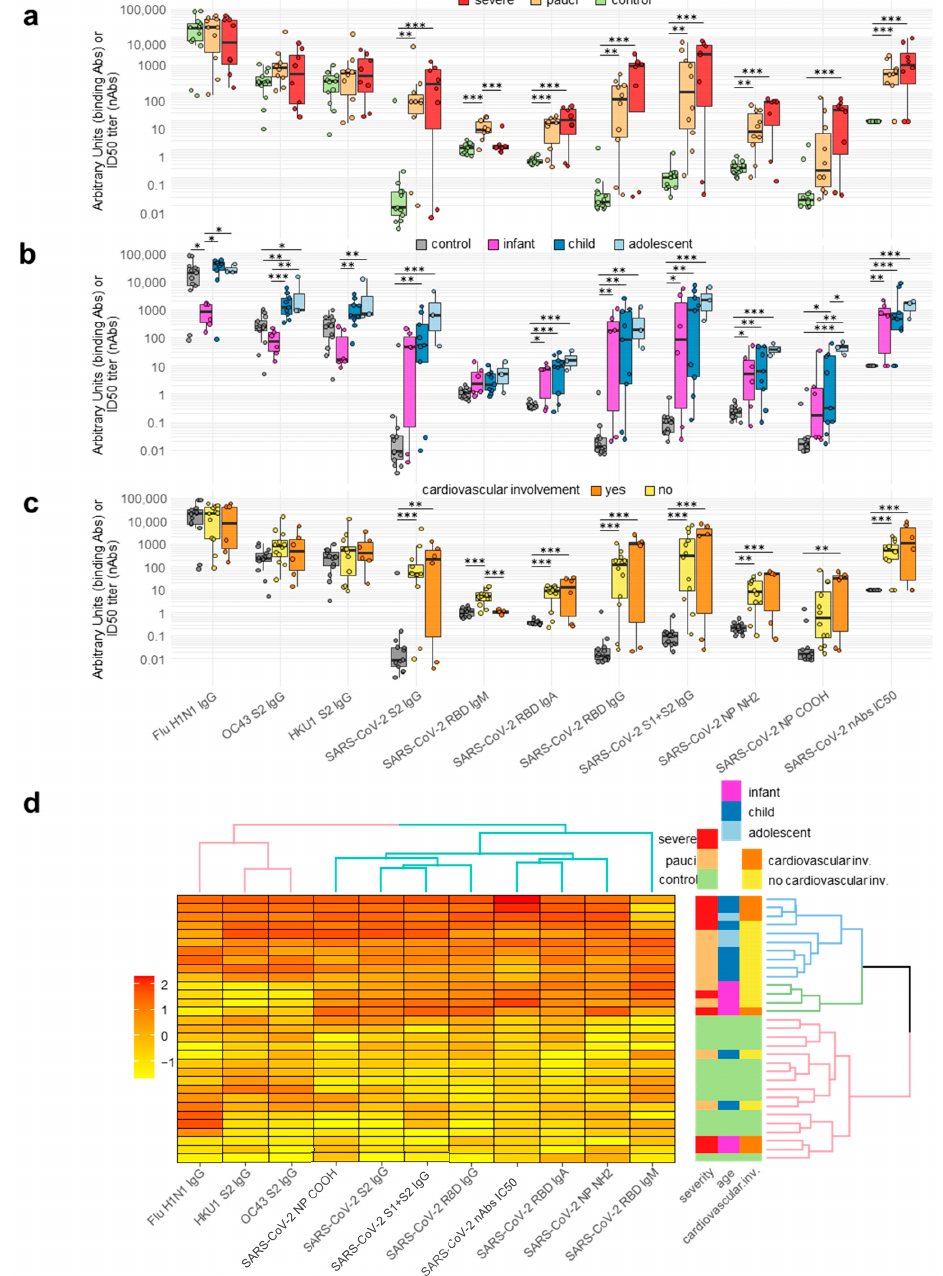
Figure 1. Antibody responses to pediatric COVID-19. Circles correspond to each subject’s antibody levels, expressed as arbitrary units for binding antibodies or IC50 titer for neutralizing antibodies. Value distributions are summarized as boxplots showing the median and interquartile range with whiskers extending to ± 1.96-fold the median. (Panel ( a )): Antibody levels in healthy controls (n = 13) and patients stratified by disease severity as paucisymptomatic/moderate (pauci, n = 10) and severe/critical (severe, n = 8). (Panel ( b )): Antibody levels in patients stratified by age as infants ( ≤ 1 year, n = 6), children (1–12 years, n = 9), and adolescents (>12 years, n = 3). (Panel ( c )): Antibody levels in patients stratified by presence (n = 6) or absence (n = 12) of cardiovascular involvement. (Panel ( d )): Heatmap of antibody levels in study subjects, expressed using linear regression upon log transformation of the data and the clustering of patients (right panel) according to antibody levels. Significant differences between groups are indicated by asterisks (ANOVA post hoc Tukey HSD test, p values adjusted for multiple comparisons, *** p < 0.001, ** p < 0.01, * p <